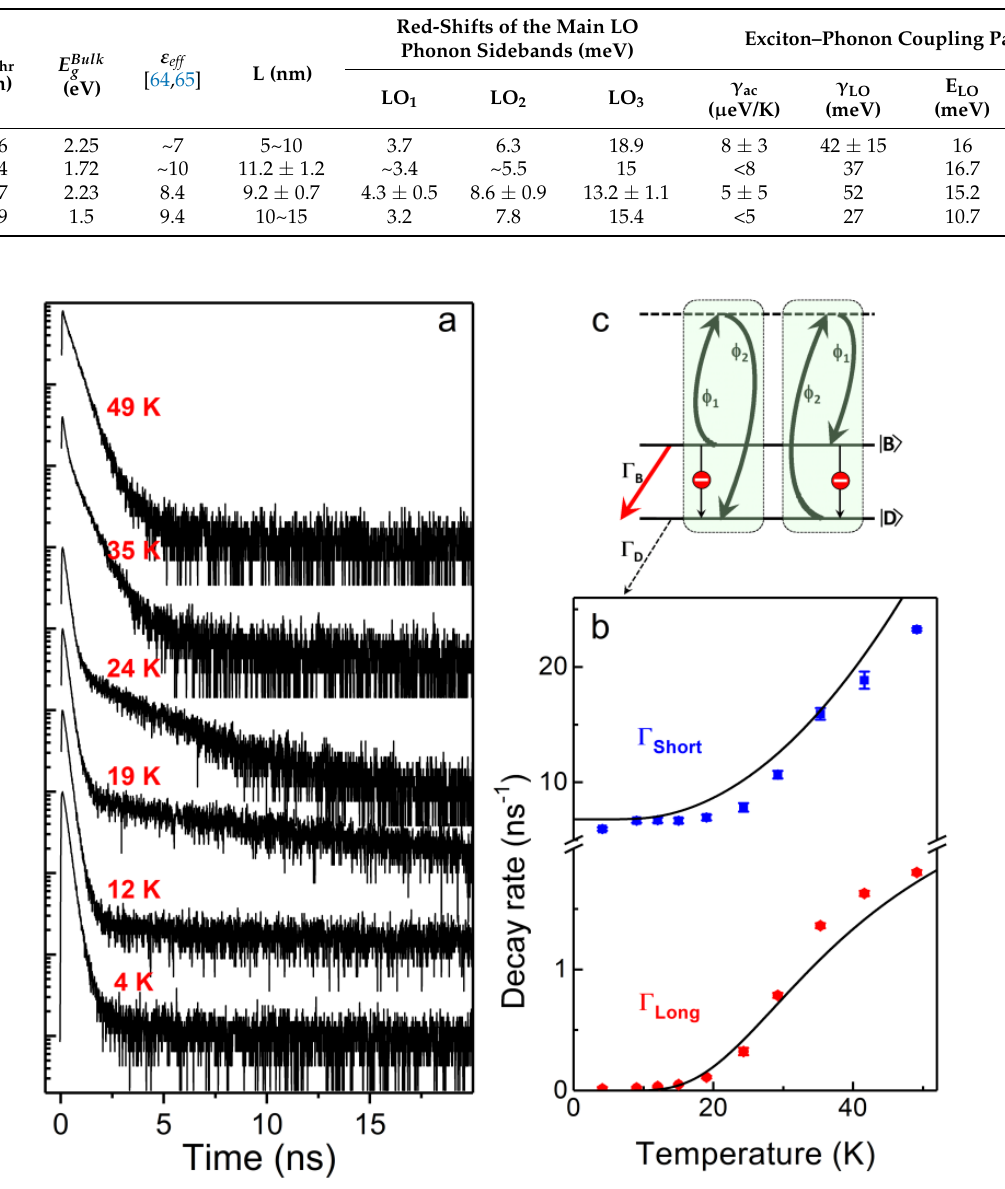
Figure 4. Exciton relaxation dynamics. ( a ) Evolution of the PL decay of a single FAPbBr 3 NC with temperature. ( b ) Temperature dependence of the short component decay rate Γ Short and the long component decay rate Γ Long extracted from the biexponential fit of the decay curves in ( a ), with 8 ns − 1 , Γ D = 10 − 4 ns − 1 , 𝛾 0 = 31 ns − 1 , 𝐸 ϕ = 5 meV and 𝐸 ϕ = 8.4 meV. ( c ) Scheme of the two-phonon 1 2 thermal mixing model between the dark state |D⟩ and one bright state |B⟩ with relaxation rates Γ D and Γ B , respectively. The red stop disk indicates that bright-to-dark relaxation with a one-pho- non process is inhibited in lead halide perovskites NCs. Adapted with permission Scheme is from ref. [42]. Copyright 2019 Springer Nature. 5. Other Charge Complexes At elevated excitation intensities, another charge complex that is commonly observed in perovskite single NC PL spectra is the biexciton, which consists of two electron-hole pairs in the NC. A biexciton can form at high excitation rates when the NC absorbs two photons simultaneously [71]. In the early ensemble studies of perovskite NC films or col- loidal solutions at room temperature, the formation of biexciton was inferred from the ultrashort lifetime (tens of picoseconds) observed in the PL decay and pump-probe tran- sient absorption measurements [71,72]. The spectral signature of biexciton has been re- vealed in the low-temperature PL spectra of single CsPbI 3 NCs [32,40], as shown in Figure 5. The spectral trail displayed in Figure 5a over the first 38 s of acquisition shows the spec- tral fingerprint of an NC in its neutral state, where the ZPLs labeled X for the exciton and XX for the biexciton show up. A signature of the biexcitonic nature of the XX structure comes from the super-linear dependence of its amplitude on the excitation intensity [35,39]. The attribution of these spectral structures is further evidenced by their perfect match when mapping the mirror image of the XX multiplet onto the X one (Figure 5b). This also allows a direct correspondence between the transition lines of the X and XX mul- tiplets. The binding energy of the biexciton can be evaluated from the energy separation